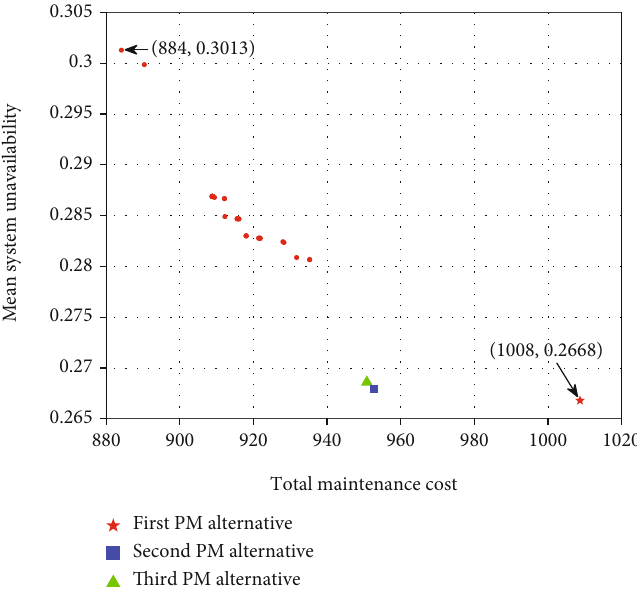
Figure 8: Pareto frontier solution set.